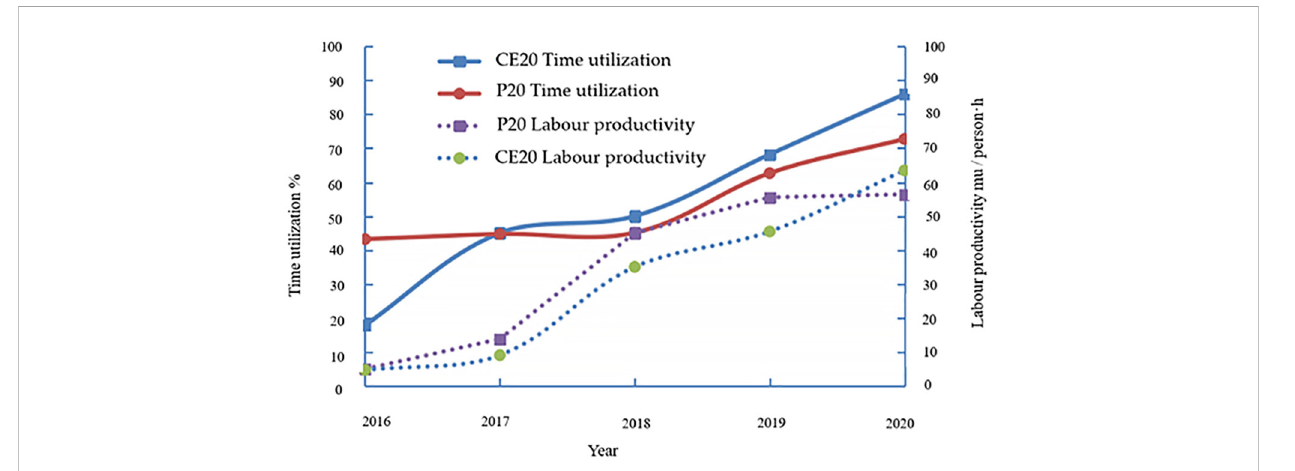
FIGURE 3 Production ef fi ciency